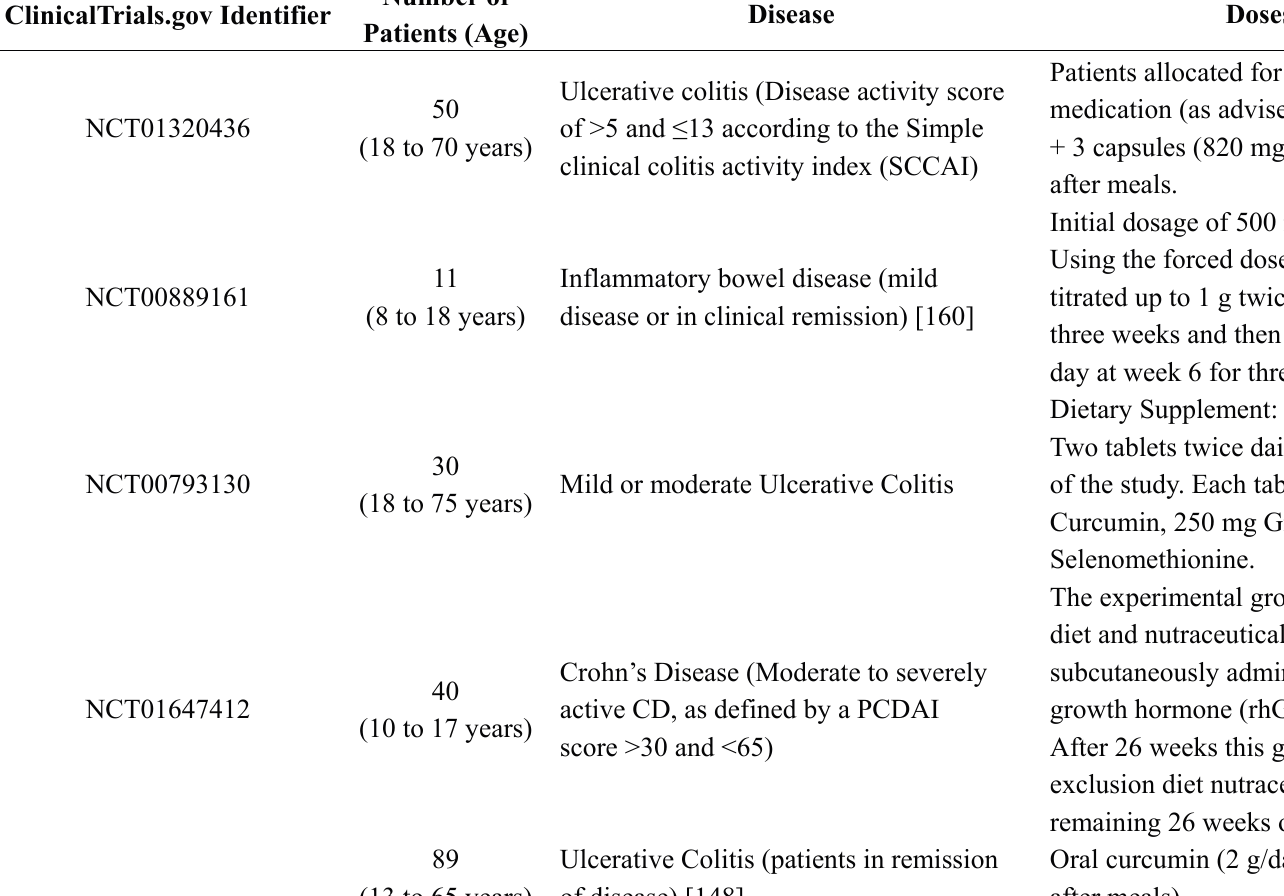
Table 4. Clinical trials to assess the efficacy of curcumin in